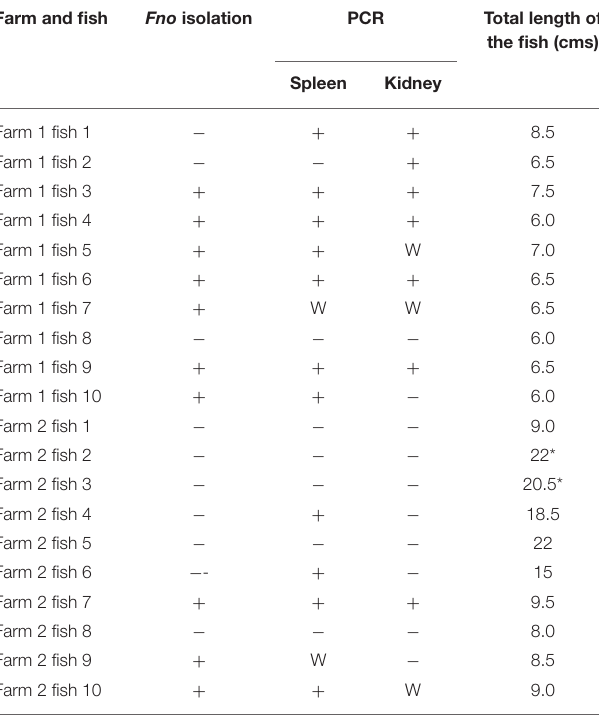
TABLE 3 | Screening of red Nile tilapia sampled during follow up visit.